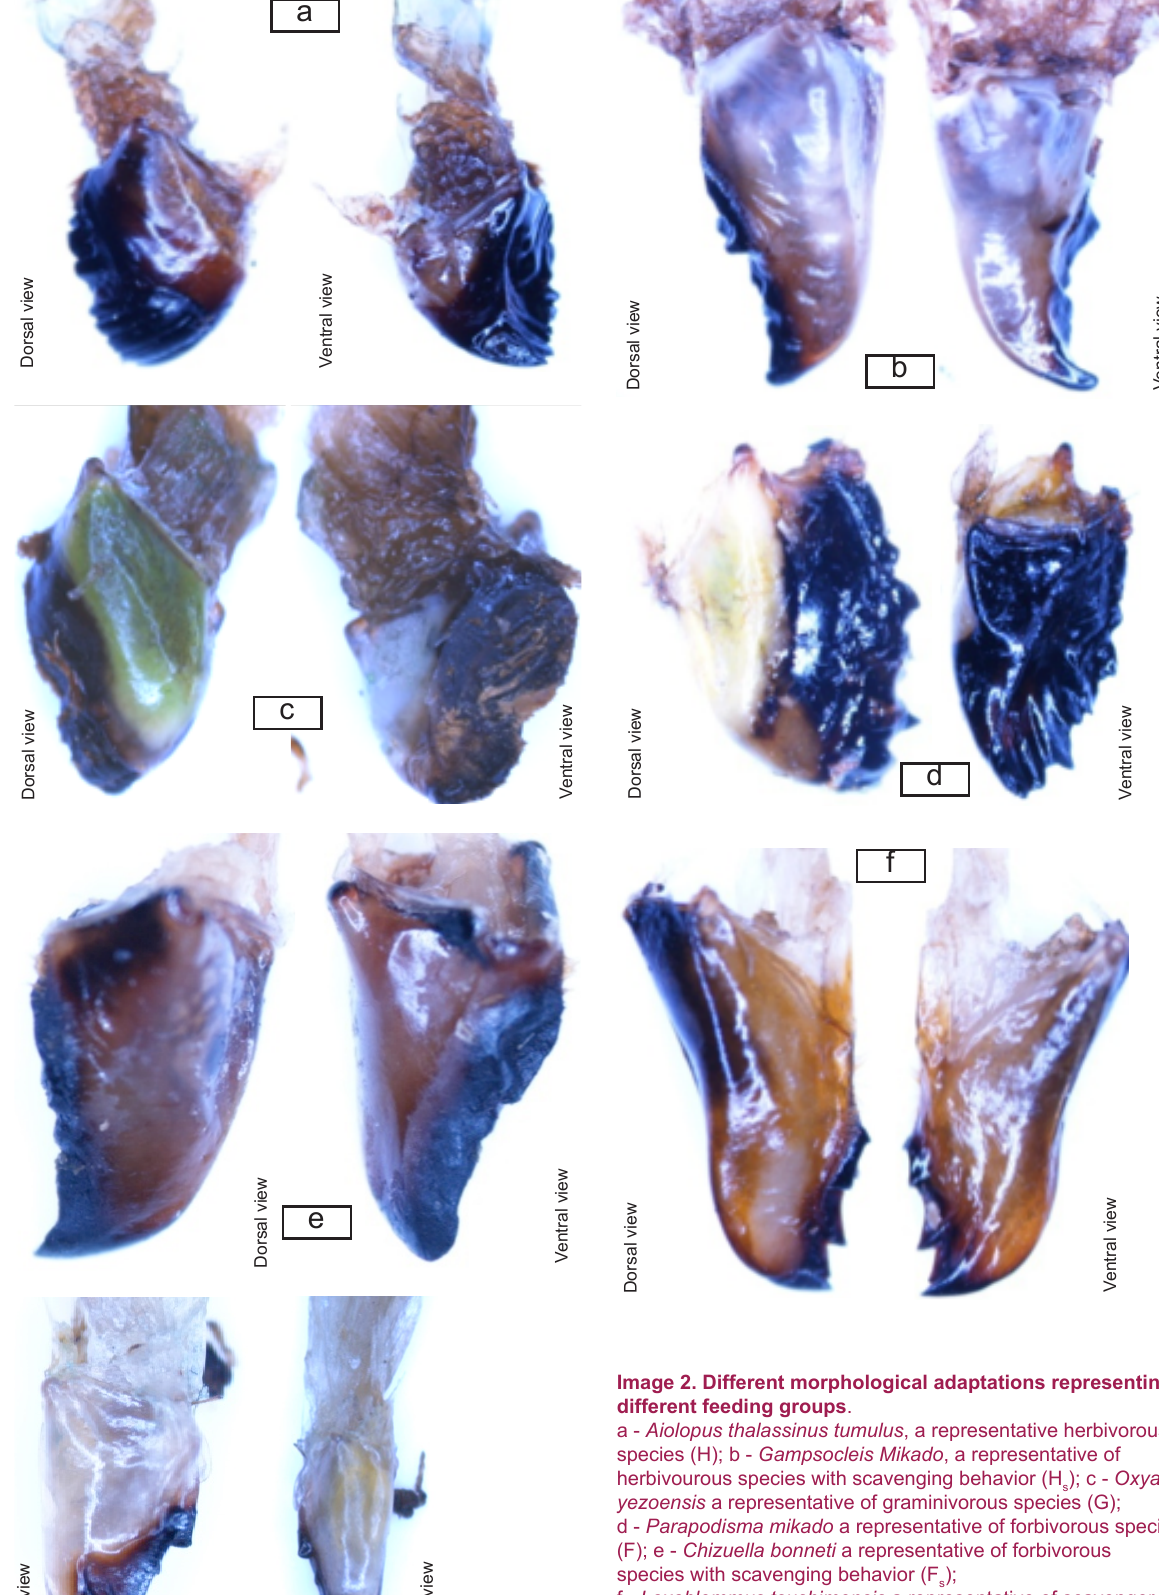
Image 2. Different morphological adaptations representing different feeding groups . a - Aiolopus thalassinus tumulus , a representative herbivorous species (H); b - Gampsocleis Mikado , a representative of herbivourous species with scavenging behavior (H ); c - Oxya s yezoensis a representative of graminivorous species (G); d - Parapodisma mikado a representative of forbivorous species (F); e - Chizuella bonneti a representative of forbivorous species with scavenging behavior (F ); s f - Loxoblemmus tsushimensis a representative of scavenger species (S); g - Tenodera angustipennis a representative of predator species